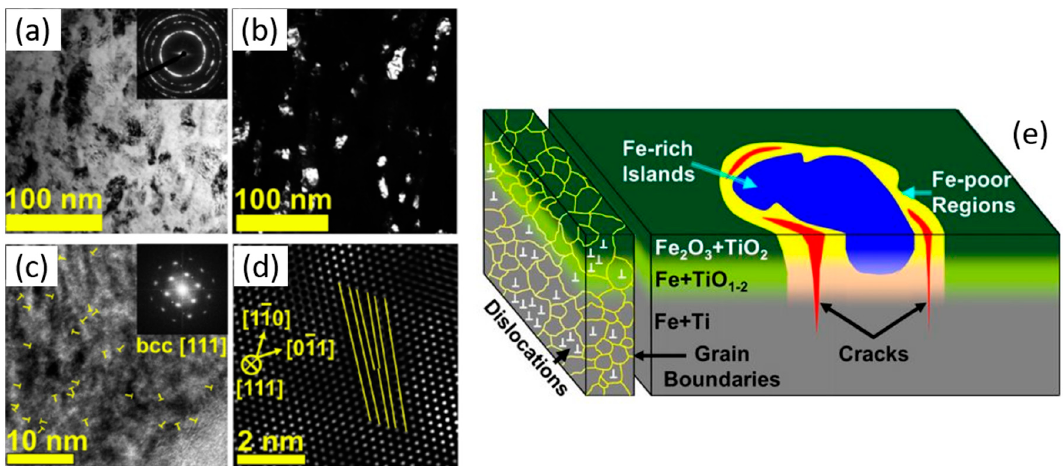
Figure 5. ( a – d ) Microstructure of a Ti-V alloy after 100 high-pressure torsion (HPT) turns. ( a ) Bright field TEM image with selected area electron diffraction. ( b ) Dark field TEM image. ( c ) High resolution TEM image and corresponding fast Fourier transform (FFT); edge dislocations are indicated by yellow T. ( d ) Atomic resolution image of an edge dislocation. Reprinted with permissions from [76] (copyright 2016 Elsevier). ( e ) Schematic illustration of the activation mechanism of TiFe by HPT (see text for detailed explanation). Reprinted with permissions from [83] (copyright: 2013 AIP Publishing).